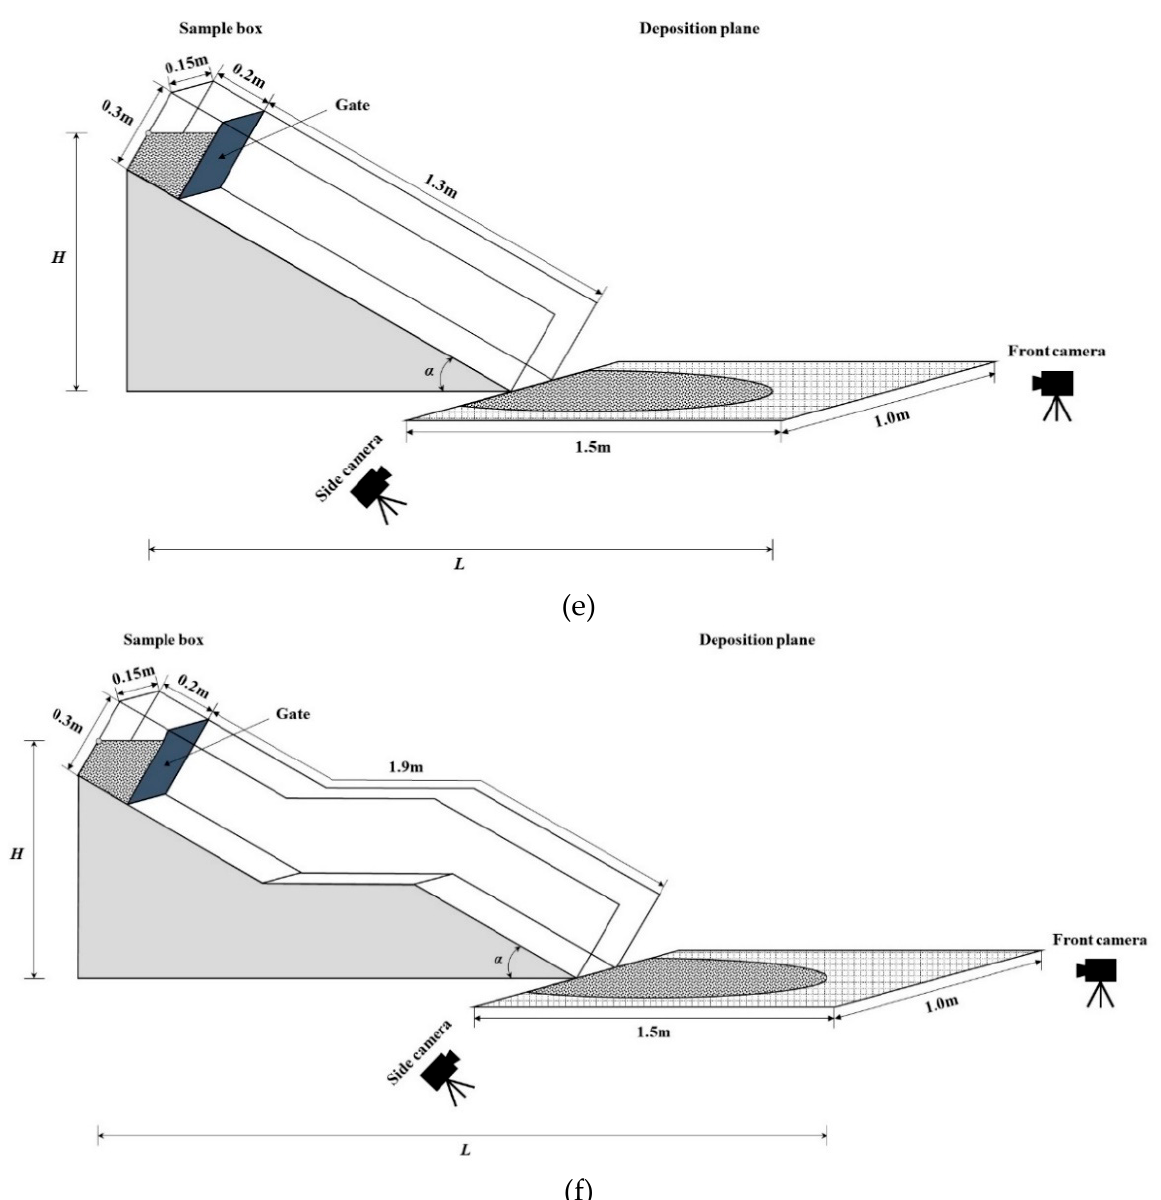
Figure 2. Experimental setups for flume experiments: ( a ) Front image of the straight channel test; ( b ) front image of the single-berm channel test; ( c ) side image of the straight channel test; ( d ) side image of the single-berm channel test; ( e ) schematic diagram of the straight channel test; and ( f ) schematic diagram of the single-berm channel test.